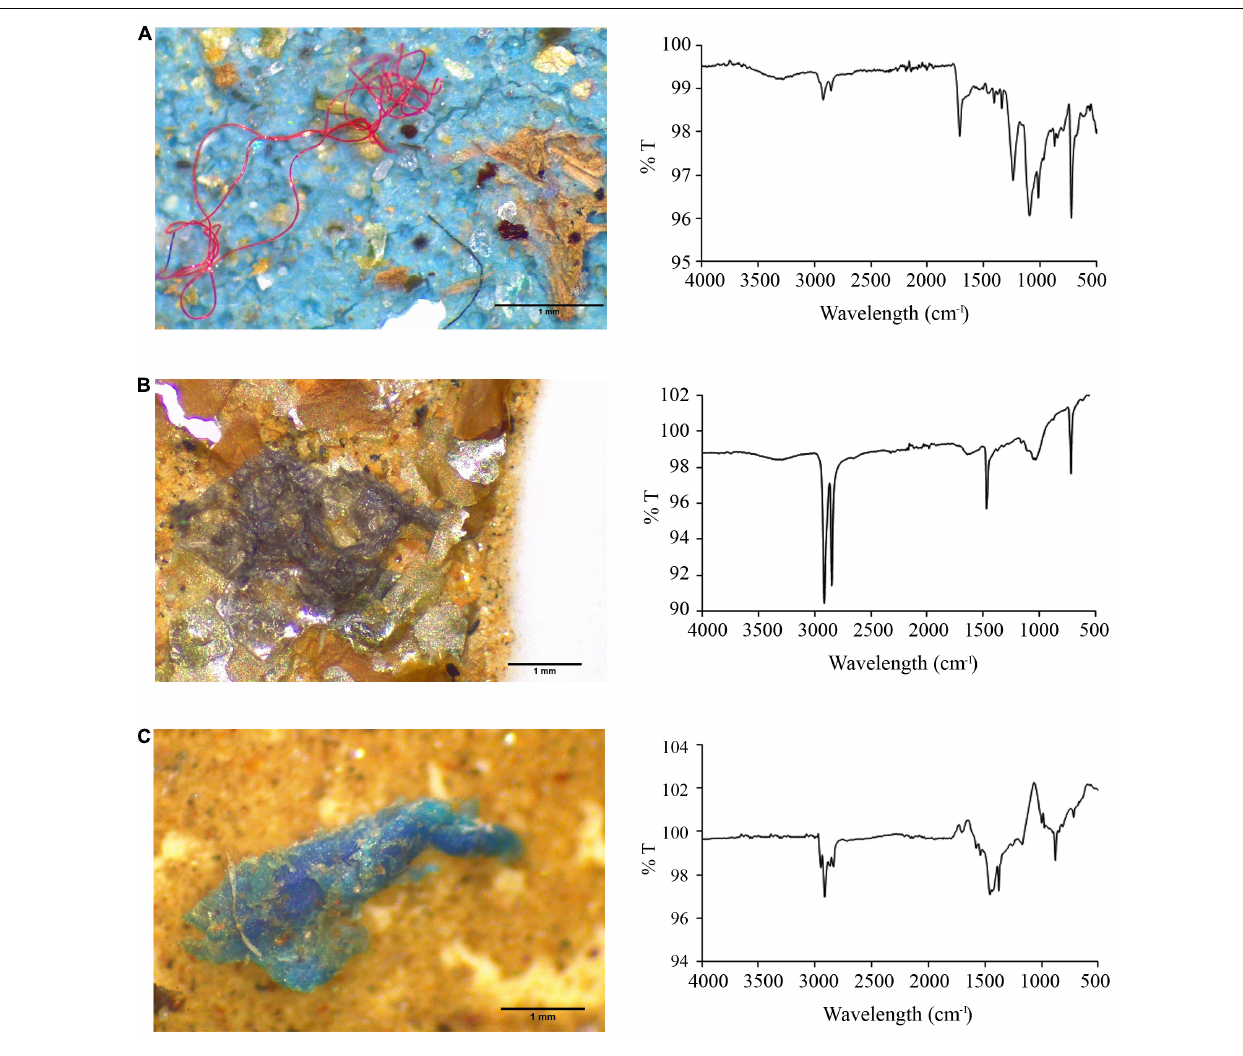
FIGURE 6 | FTIR spectrum of MPs in beach sediments of Kuakata, Bangladesh, (A) PET; (B) PE; (C) PP.